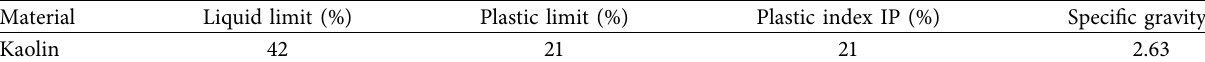
Table 1: Physical properties of kaolin.